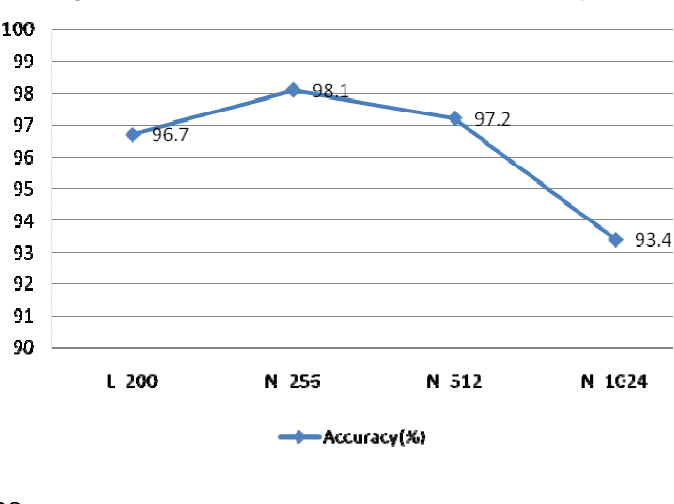
Figure 26. Comparison of different FFT lengths.